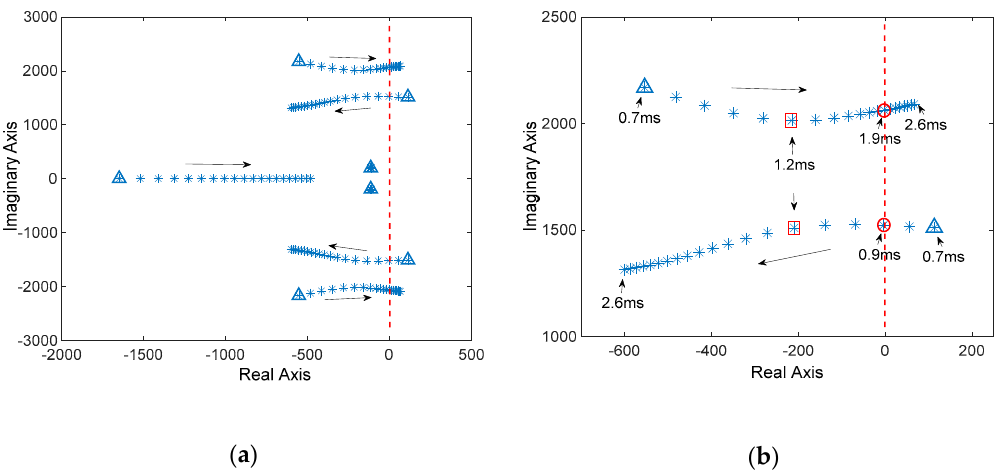
Figure 7. ( a ) Root-locus diagram of the studied dc microgrid system with NDO time constant varying from 0.7 ms to 2.6 ms; ( b ) Zoom.